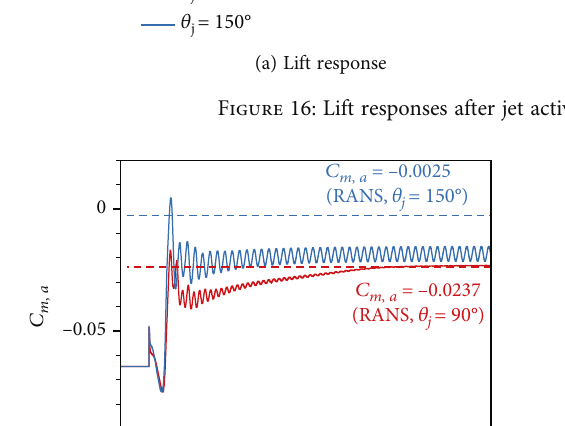
Figure 16: Lift responses after jet activation at M